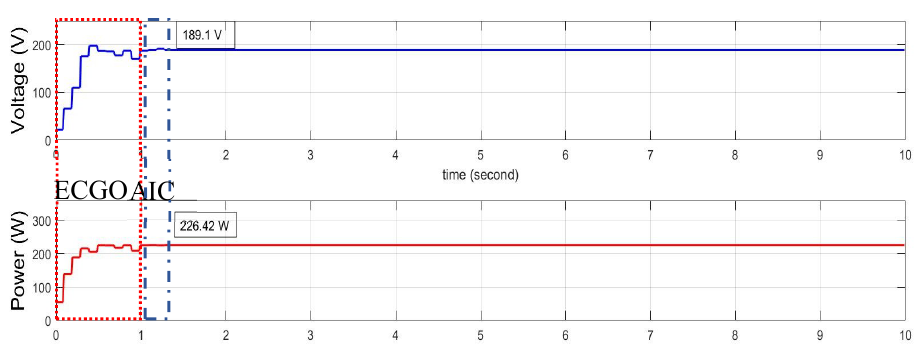
Figure 8. Tracking scheme example of the proposed method.